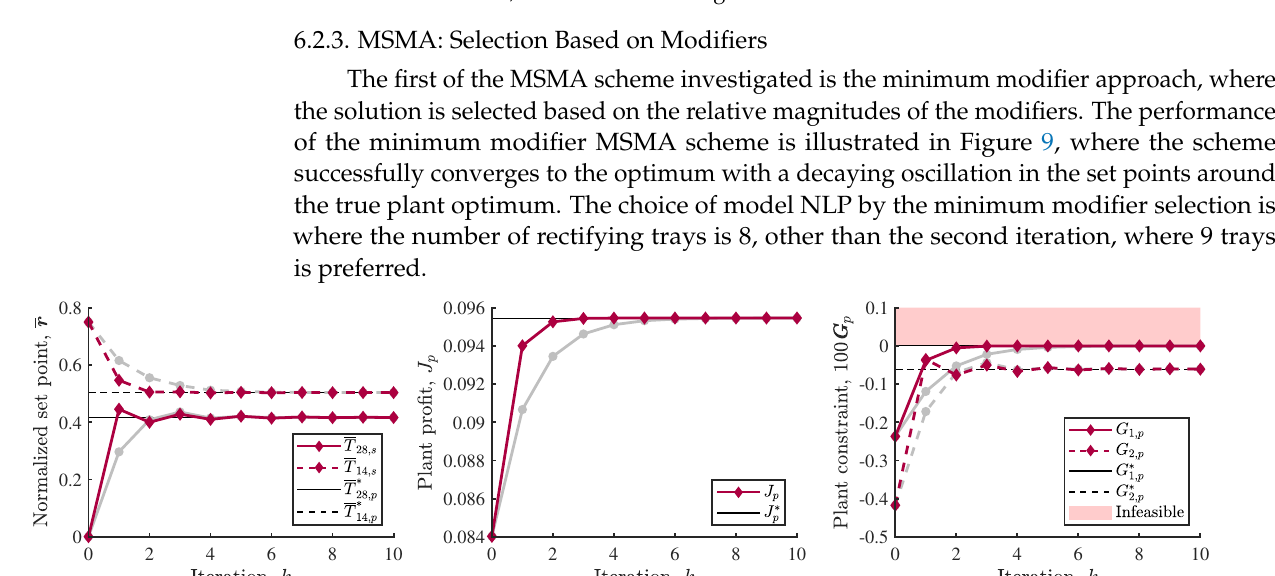
Figure 8. Distillation column RTO trajectory for standard MA. Top row, unstable solution using K = 0.9 I . Bottom row, stable solution using K = 0.6 I .